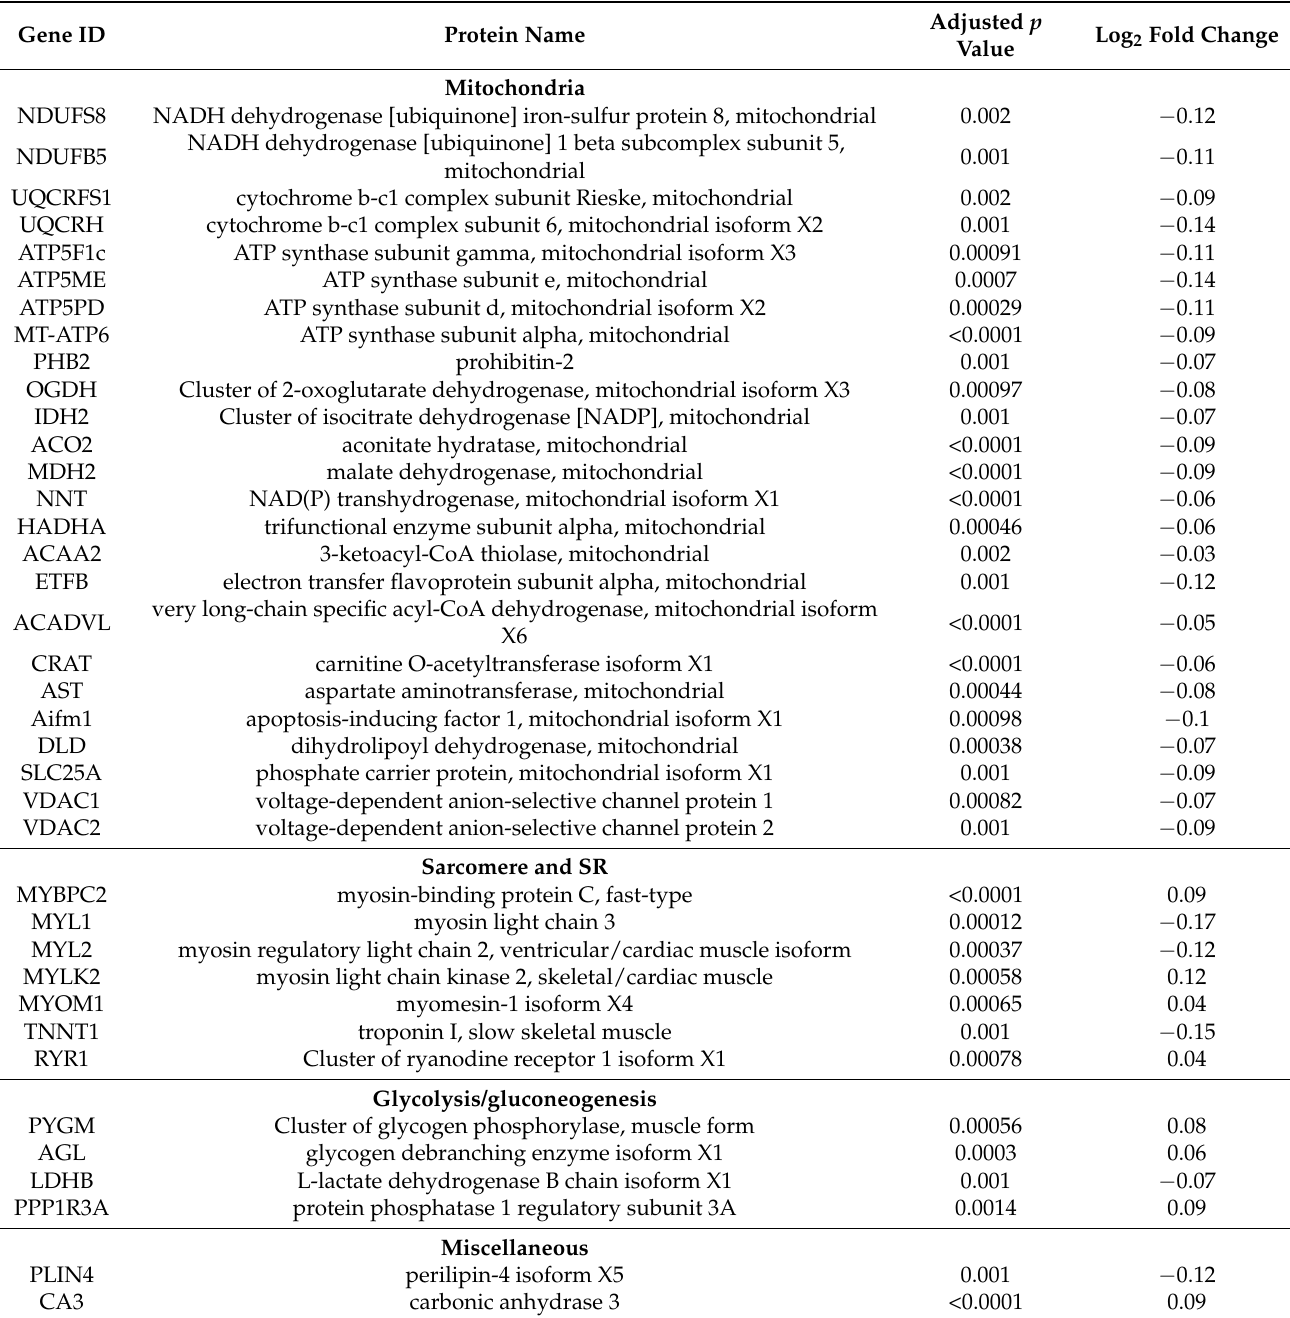
Table 2. The gene identification for protein, protein name, p value adjusted for multiple test correc- tions, and log 2 fold change for differential expressed proteins comparing CoQ10 supplementation to the control